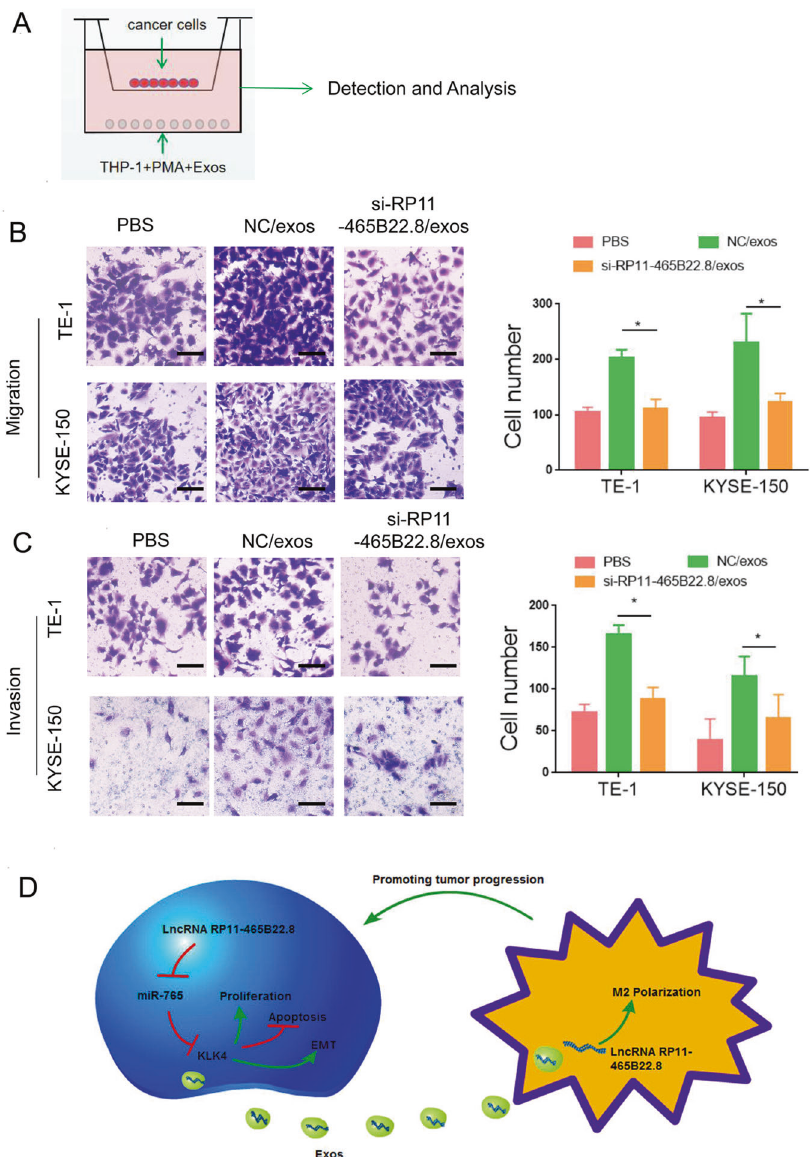
Fig. 7 Exosomal lncRNA RP11-465B22.8 triggers M2 macrophage-mediated mobility in EC cells. A Schematic image indicating the coculture/migration system for macrophage migration analysis. B , C The migration and invasion abilities of PMA-induced macrophages after treatment with exosomes from KYSE-150 cells transfected with si-RP11-465B22.8 (si-RP11-465B22.8/exos) or control siRNA (NC/exos). D Schematic illustration of the mechanism by which lncRNA RP11-465B22.8 promotes EC progression. In EC cells, lncRNA RP11-465B22.8 elevates KLK4 expression by sponging miR-765, thus facilitating EC cell proliferation and migration. In addition, exosomal RP11-465B22.8 derived from EC cells promotes M2 polarization of macrophages, which further enhances EC